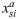
Three representations of a multiple sequence alignment comprised of M sequences and L positions.A, ascii text. B, a three-dimensional binary array xsia, in which xsia=1 if sequence s has amino acid a at position i, and 0 otherwise; gaps are always set to 0. In this representation, the frequencies of amino acids at individual positions are fia=〈xsia〉s≡∑swsxsia/M′, where ws is the weight for each sequence s and M′ = ∑s
ws represents the effective number of sequences in the alignment. Joint frequencies of amino acids between pairs of positions are defined by fijab=〈xsiaxsjb〉s≡∑swsxsiaxsjb/M′. C, a two-dimensional alignment matrix Xsn, in which the index s (along rows) represents sequences and the index n (along columns) represents the combination of amino acid and position dimensions in one, such that n = 20(i − 1) + a. This representation is useful in explaining the relationship between patterns of coevolution between amino acids and patterns of sequence divergence in the protein family (see Eq (12)).